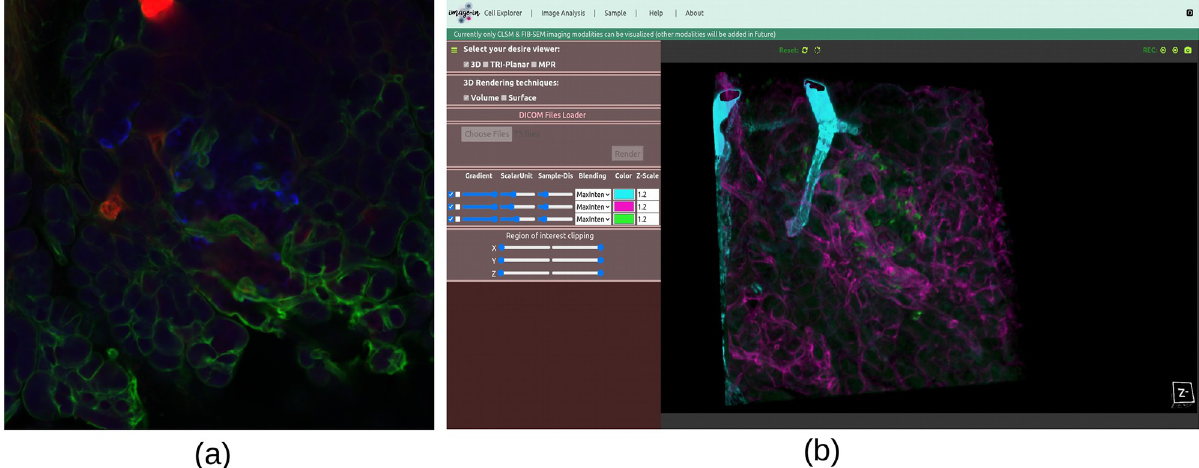
Fig 7. (a) Example of a three-channel human islet microvasculature [42] CLSM dataset volume rendered in (b) Each channel is rendered with a different color: Channel-1 is cyan, Channel-2 is magenta, and Channel-3 is green.